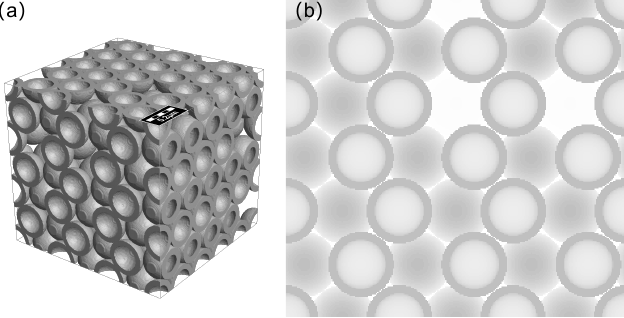
Figure 8. Renderings of the hexagonal close packing (HCP) foams with vacancy defect: Perspective ( a ) and top view ( b ).